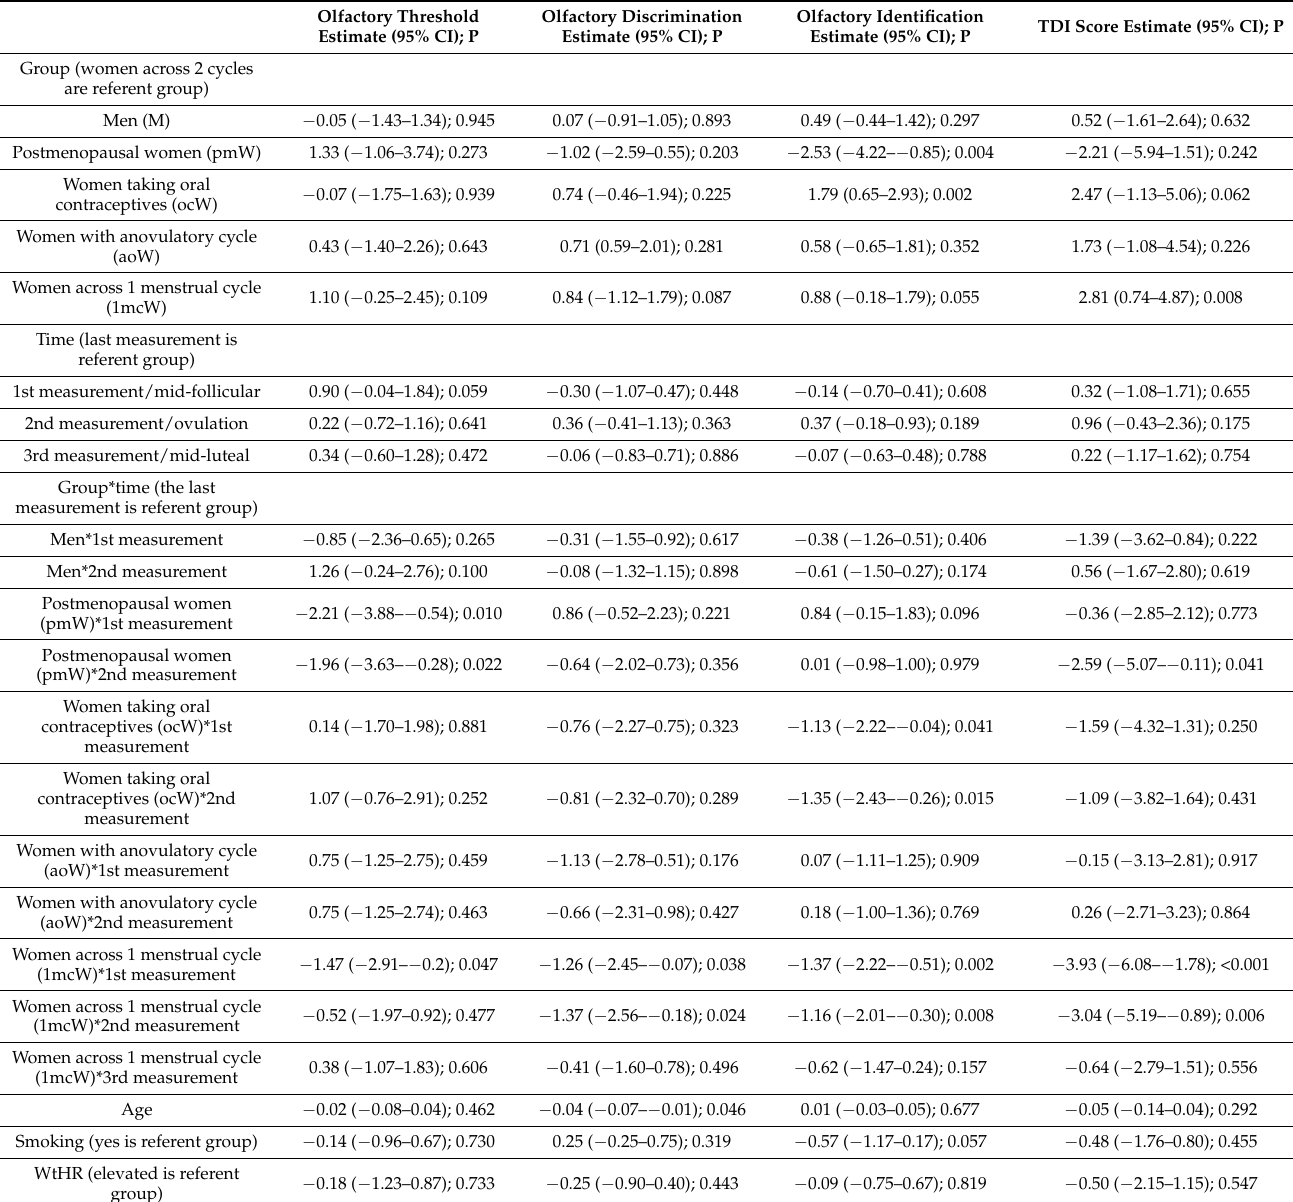
Table 3. Differences in olfactory perception across study groups and measurements or menstrual cycle phases, using linear mixed models controlled for age, smoking, and waist-to-height